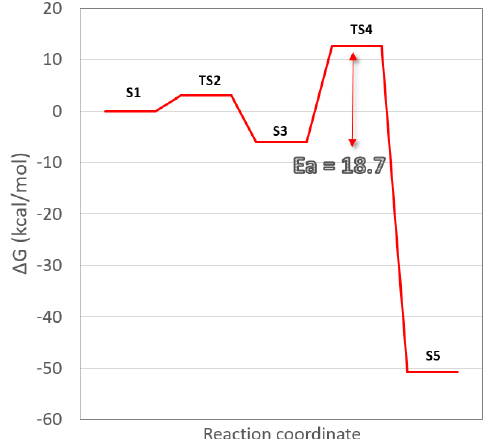
Figure 3. Free energy ( Δ G) profile for the formation of Guanine–Guanine intercross link.